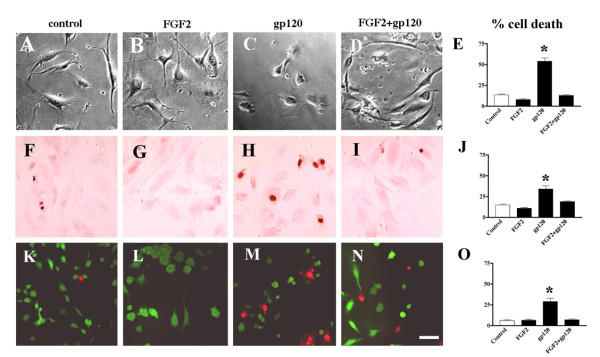
Cell viability assays for FGF2 protection of HUVEC against gp120-mediated toxicity (A-D) Phase contrast, (F-I) TUNEL staining, and (K-O) fluorescent staining of HUVEC. Panels A, F, and K show images of untreated HUVEC control; B, G, and L show HUVEC treated for 24 h with FGF2 (20 ng/ml); panels C, H, and M show HUVEC treated for 24 h with gp120 (25 ng/ml) and panels D, I, and N show HUVEC pre-treated with FGF2 for 24 h before a 24 h exposure to gp120. Panels E, J and O show the percentage of cell death as determined by Trypan blue exclusion, percentage of DNA fragmentation by TUNEL and FA/PI staining, respectively. Results shown in panels E, J and O represent the average of three separate experiments performed in triplicate. * = P < 0.05 by One-Way ANOVA with post-hoc Dunnett's when compared to control. Bar = 20 microns.